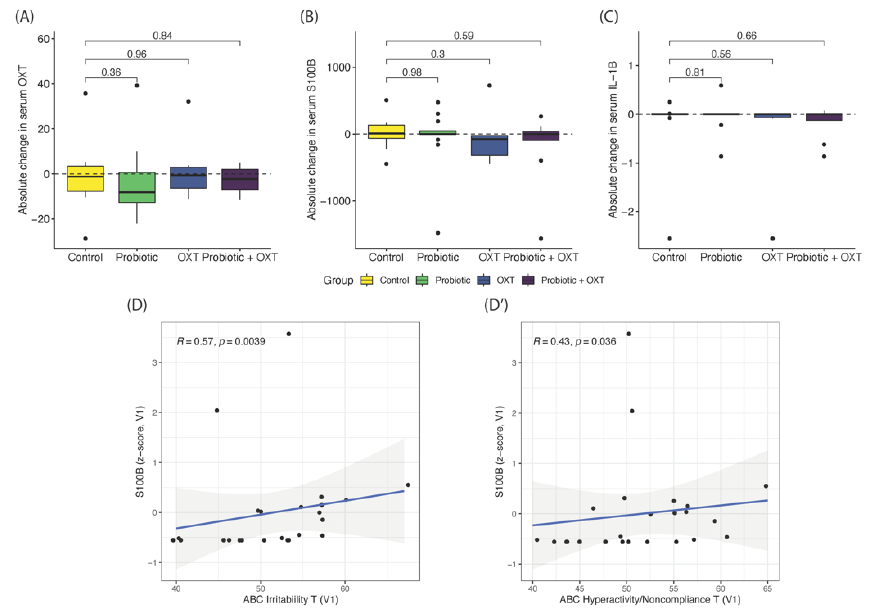
Figure 5. Summary of longitudinal serum marker changes and associated correlations. Absolute changes in serum OXT ( A ), S100B ( B ), and IL-1β ( C ) levels, comparing each treatment group against controls. Baseline serum S100B is positively correlated with ABC irritability T ( D ) and ABC hyperactivity/noncompliance T-scores ( D’ ).